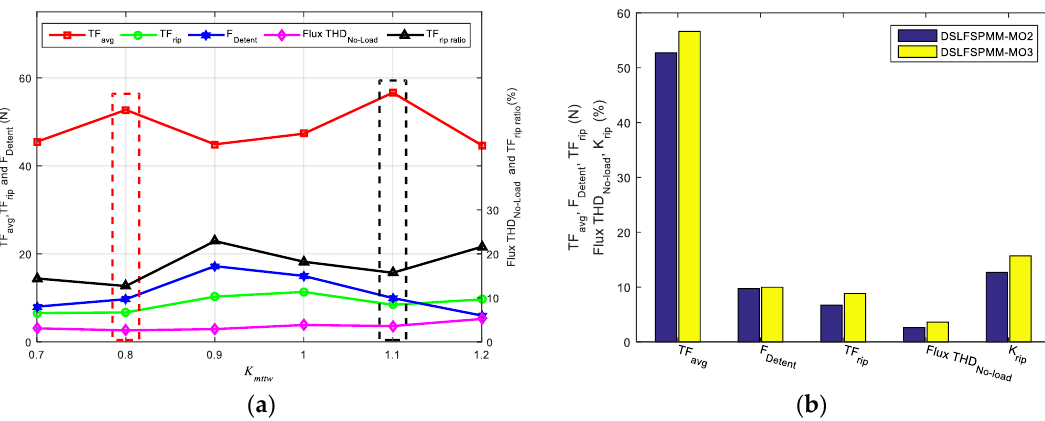
Figure 14. Mover tooth tip width optimization: ( a ) Performance comparison of DSLFSPMM-MO2 having different 𝐾 𝑚𝑡𝑡𝑤 values; ( b ) Performance comparison of DSLFSPMM-MO2 and DSLFSPMM- MO3. Table 9. Modified parameter and performance comparison of DSLFSPMM-MO2 with DSLFSPMM-MO3.